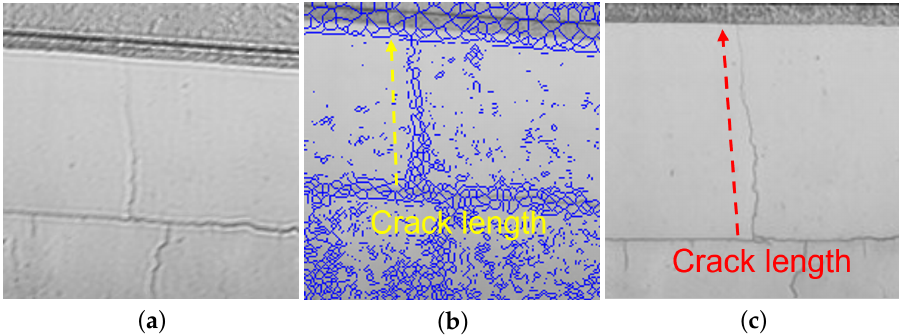
Figure 16. Three cracks captured by a fixed camera.